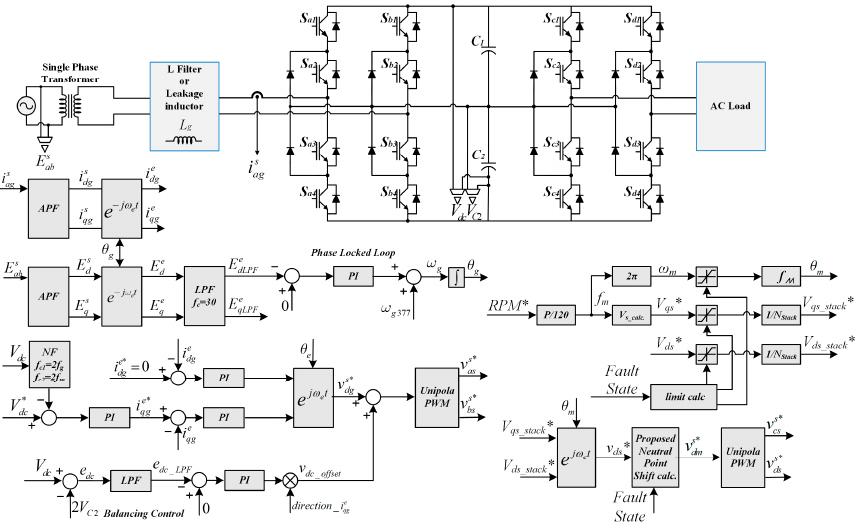
Figure 12. Proposed fault-tolerance control block diagram.